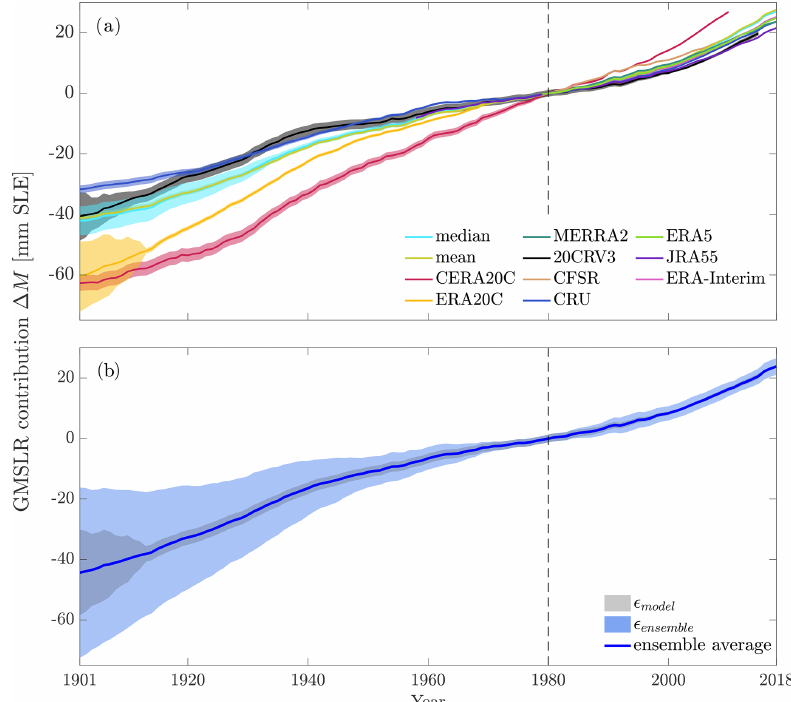
Figure 6. (a) Estimates of temporally accumulated global mean sea-level rise (GMSLR) contribution relative to 1980 for all forcing data sets. Shaded areas are model uncertainties calculated for individual model setups. (b) Ensemble mean output estimate. Shaded areas are the mean model uncertainty (grey, (cid:15) model ; see Eq. 10) and total ensemble uncertainty (blue, (cid:15) ensemble ; see Eq. 11), which are shown at the 90% confidence level. Results of the CERA20C forcing are excluded from the ensemble mean (see Sect.